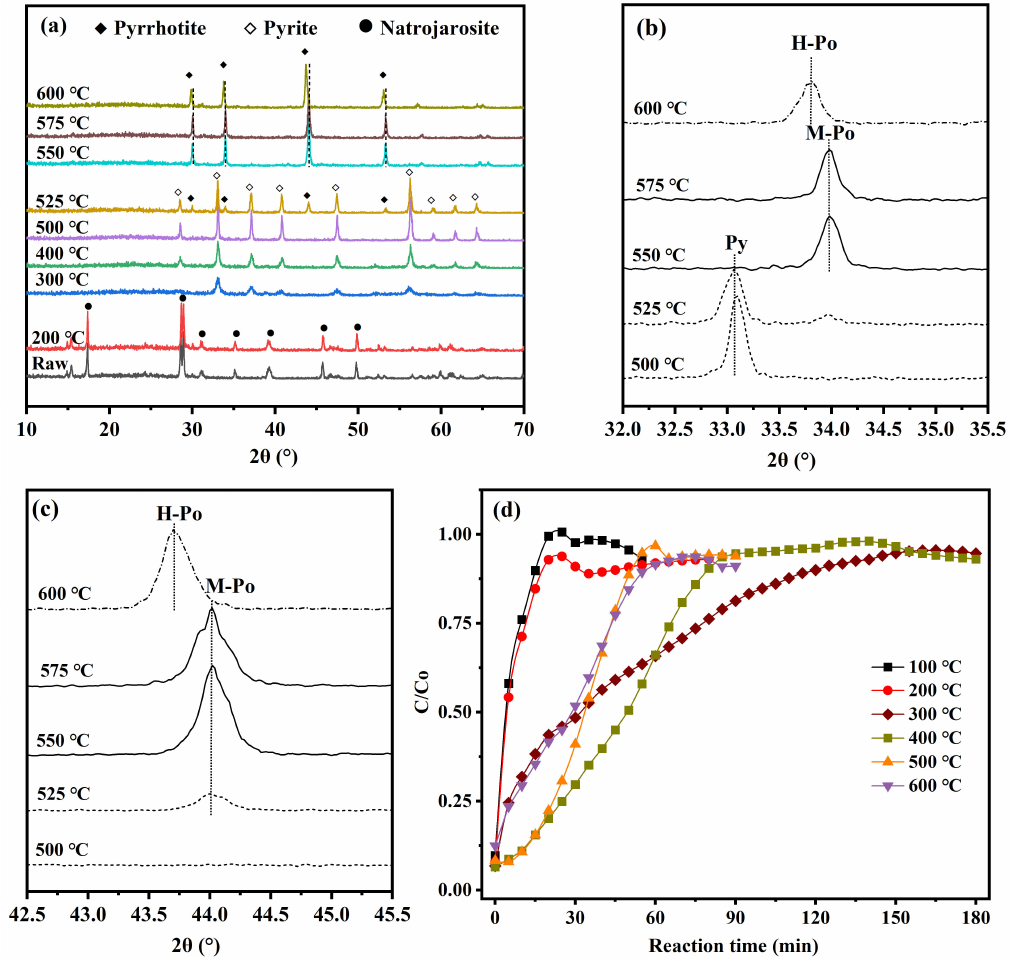
Figure 3. ( a ) XRD patterns of sulfidation products of jarosite residues under various temperatures (sulfidation conditions: 200–600 ◦ C, 1.5 h, 40 mL/L, 3% H 2 S, and 97% N 2 balance gas); ( b , c ) partially enlarged areas of ( a ), where ( b ) corresponds to the lattice plane of (203) and ( c ) to the lattice plane of (206) of M-Po; ( d ) the breakthrough curves of H 2 S (C and C 0 are H 2 S concentrations in effluent and initial gases,